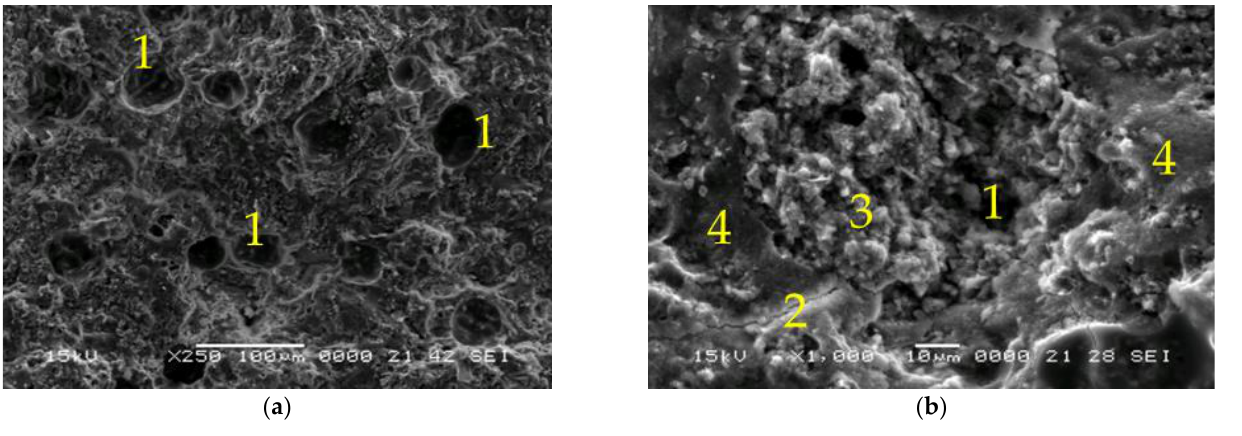
Figure 6. SEM micrographs of: ( a , b ) Sample 6M, ×250, respectively, ×1000 magnification (1 — pores, 2 — microcracks, 3 — partially reacted fly ash and 4 — dense zone of reacted fly ash) .